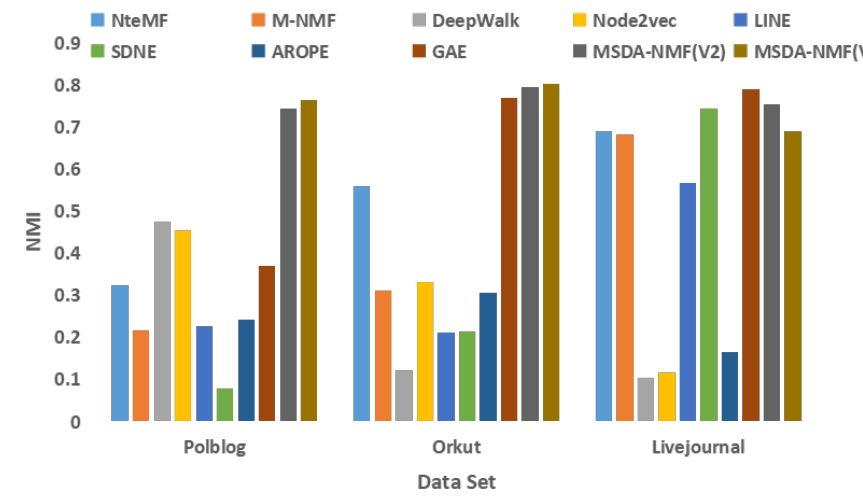
Figure 4. Evaluation of node clustering performance based on NMI.